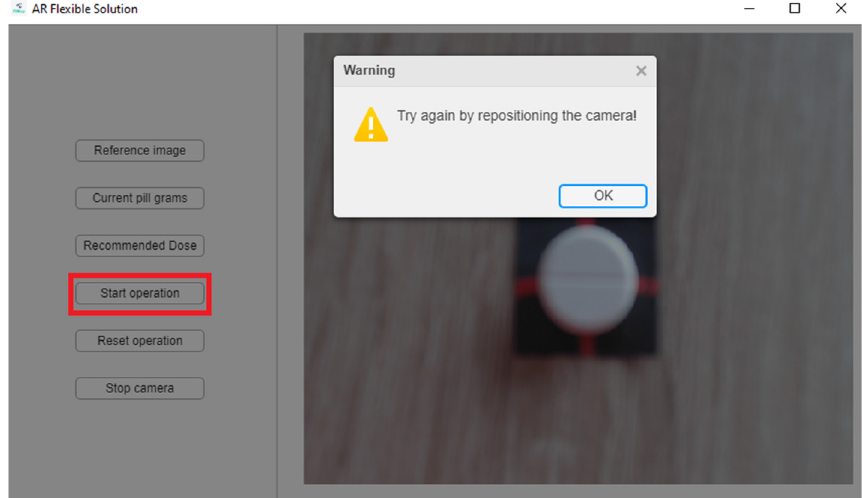
Figure 8. Error in pill identification.